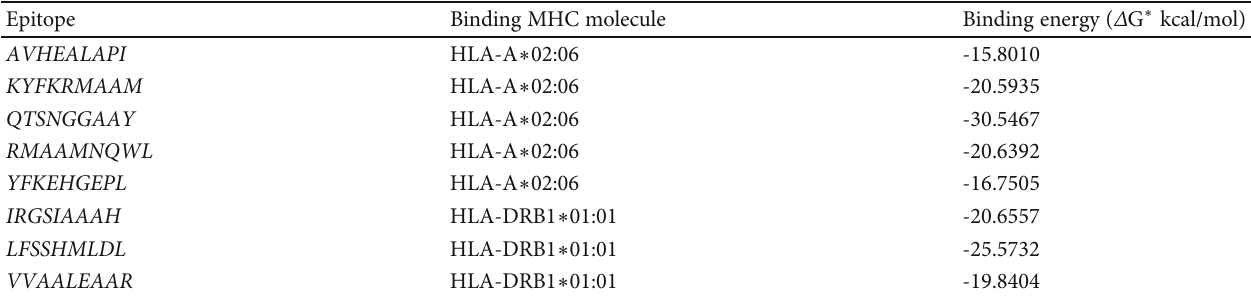
Table 7: Docking results of the most promiscuous epitopes that show the best binding a ffi nity.